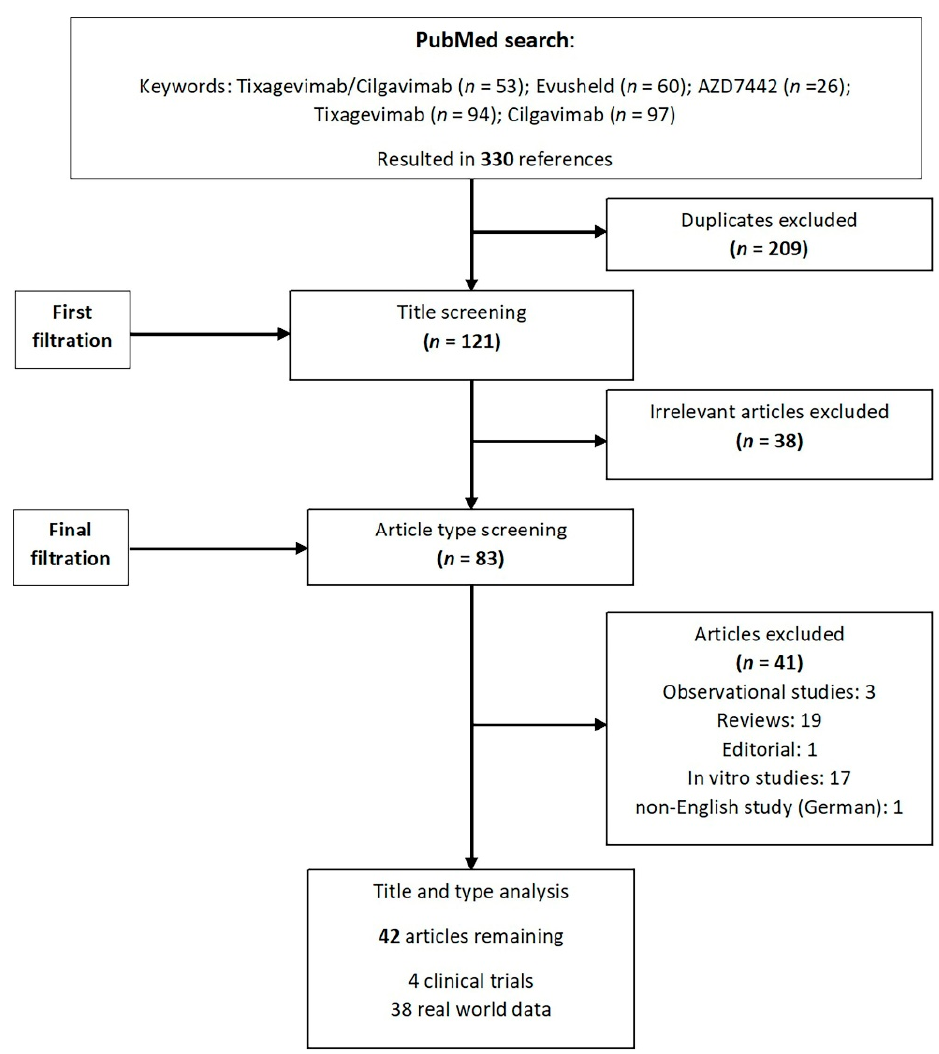
Figure 1. Flowchart of included and excluded studies.